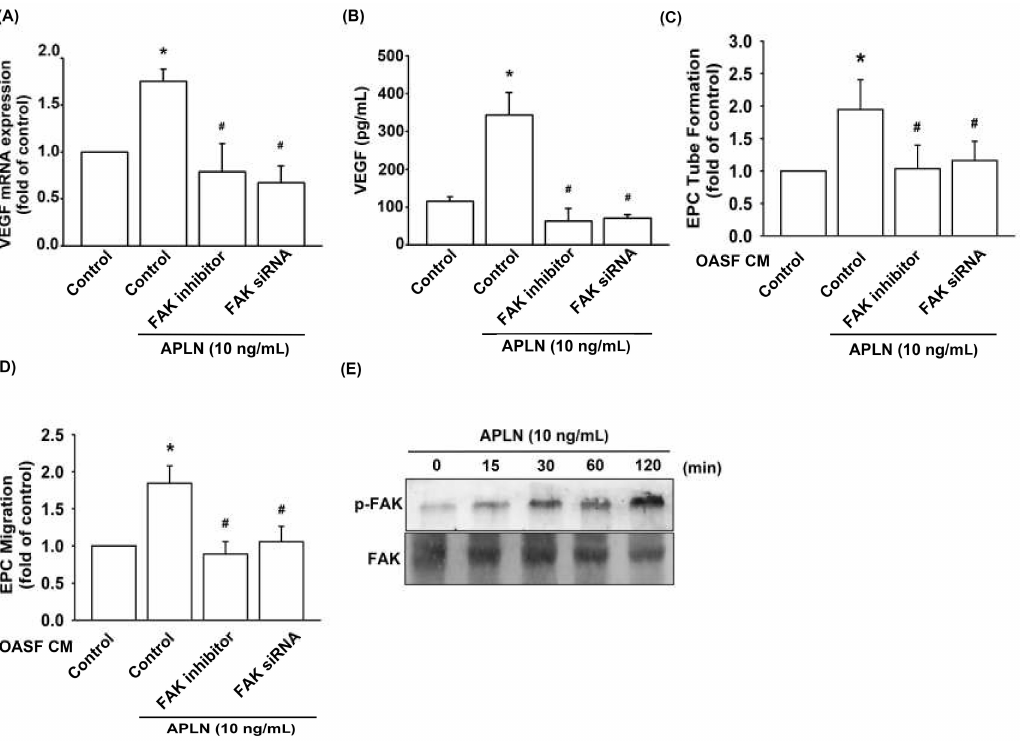
Figure 3. Focal adhesion kinase (FAK) phosphorylation is involved in APLN-induced VEGF synthesis. ( A , B ) OASFs were pretreated with a FAK inhibitor for 30 min or FAK small interfering RNAs (siRNA) for 24 h, then incubated with APLN (10 ng / mL) for 24 h. ( A ) VEGF levels were examined using RT-qPCR ( n = 4) and ELISA assay ( n = 5). ( C , D ) OASF culture medium collected after APLN incubation was subjected to EPC ( C ) tube formation ( n = 5) and ( D ) migration assays ( n = 5). ( E ) OASFs were incubated with APLN for the indicated time intervals, and the extent of FAK phosphorylation was examined using Western blot analysis. * p < 0.05 compared with control; # p < 0.05 compared with the APLN-treated